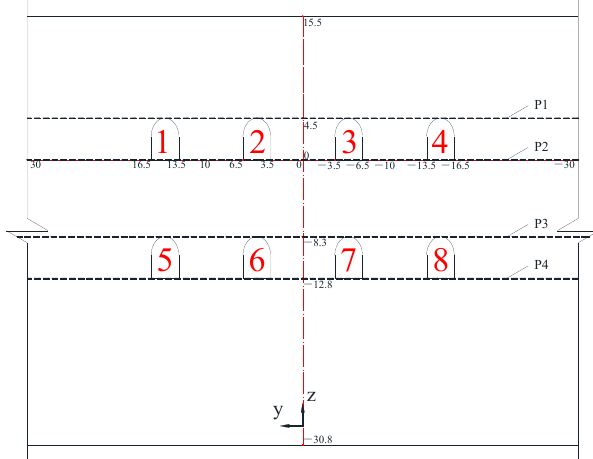
Figure 4. Monitoring planes.